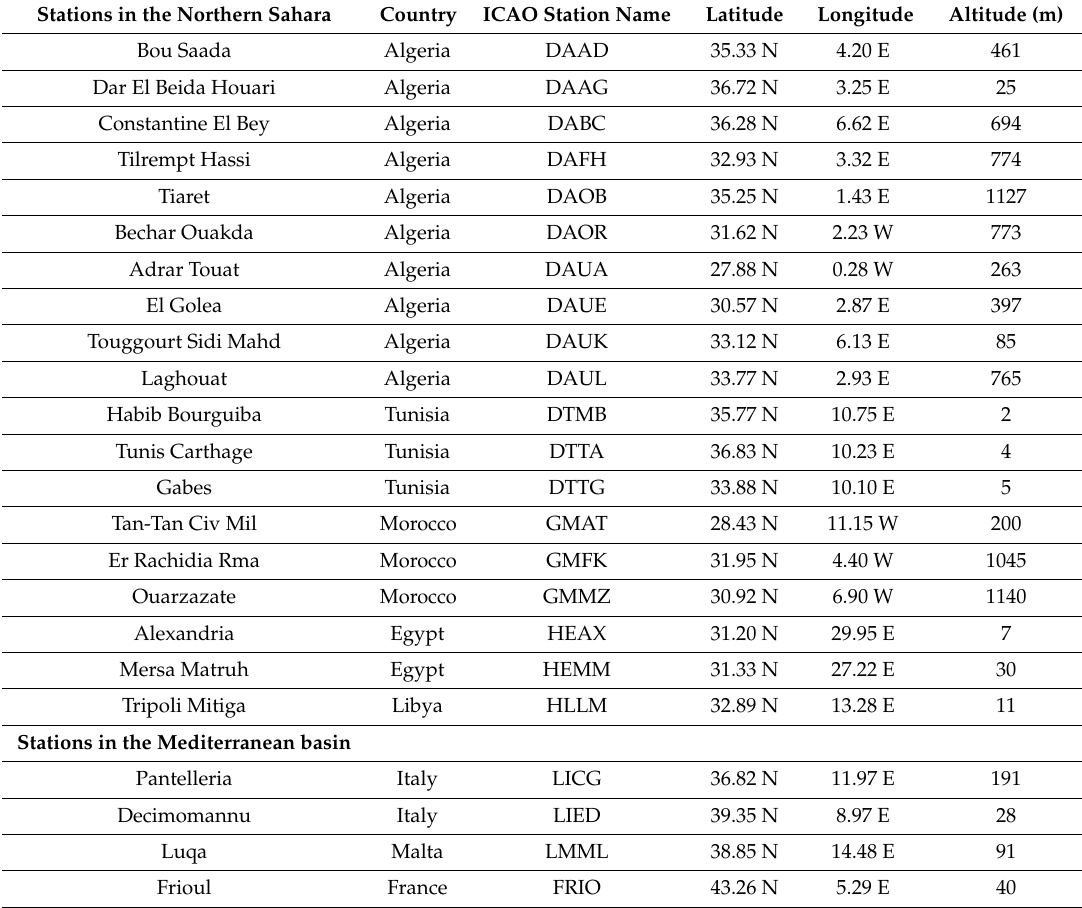
Table 3. Acronym and position (lat, lon, elev) of the meteorological aviation reporting (METAR) stations. Stations in the Northern Sahara Country